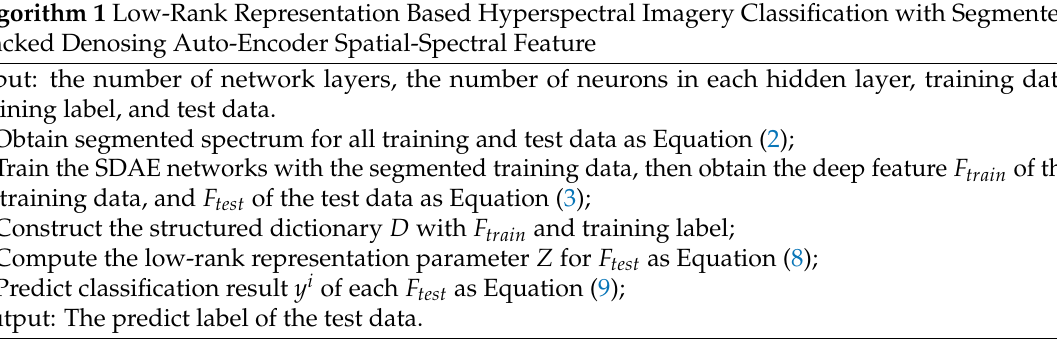
Algorithm 1 Low-Rank Representation Based Hyperspectral Imagery Classification with Segmented Stacked Denosing Auto-Encoder Spatial-Spectral